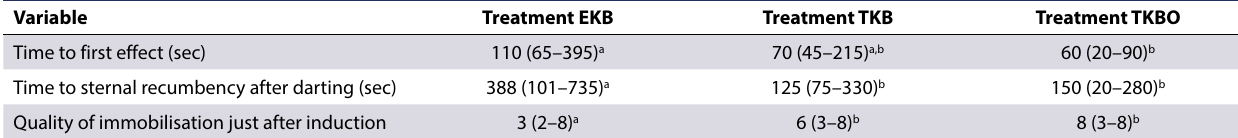
Table II: Time (seconds) to first effect and sternal recumbency after darting, and quality of immobilisation just after induction, in black-faced impala ( Aepyceros melampus ssp. petersi ) administered 2.0 mg etorphine, 50 mg ketamine, and 10 mg butorphanol, (treatment EKB) or 2.0 mg thiafentanil, 50 mg ketamine, and 10 mg butorphanol (treatment TKB) or 2.0 mg thiafentanil, 50 mg ketamine, and 10 mg butorphanol with supplemental